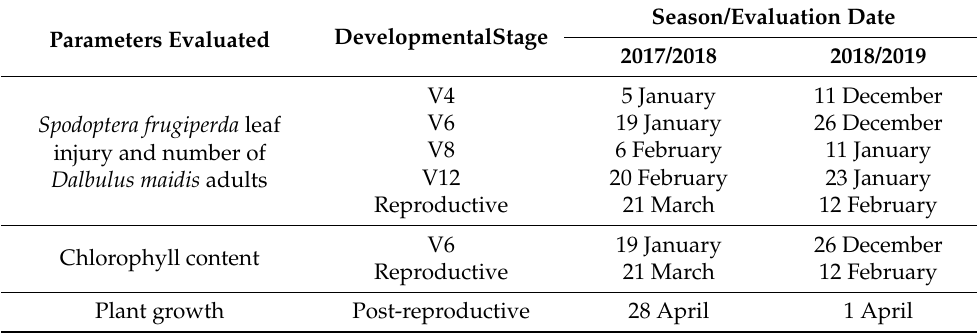
Table 1. Evaluations of maize genotypes in an experimental site of the Lavras Federal University in the municipality of Lavras, Minas Gerais state, Brazil, and the respective